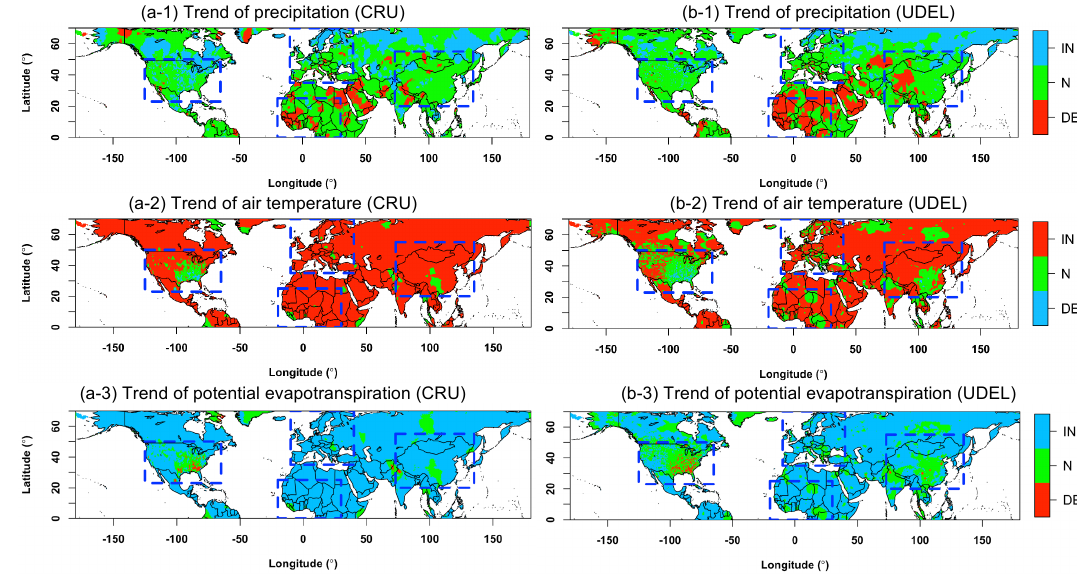
Figure 4. Trends in annual precipitation, annual average temperature and annual potential evapotranspiration based on the CRU and UDEL datasets. The colored regions correspond to regions of IN, N and DE, which indicate a statistically positive (increasing) trend, no trend and a negative (decreasing) trend, respectively, at a significance level of